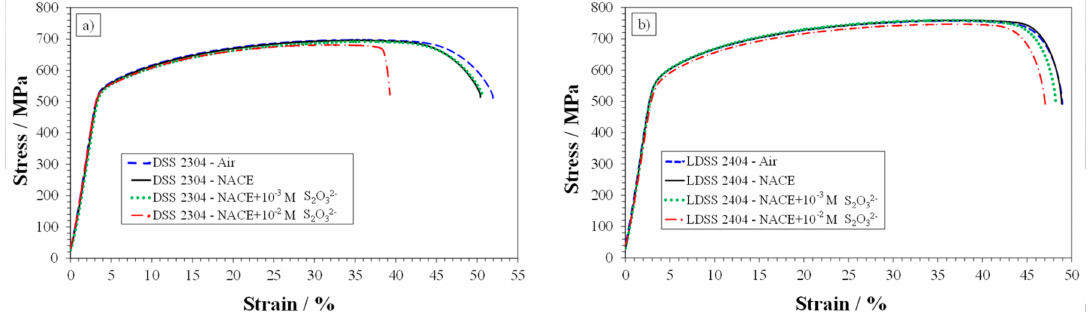
Figure 10. Stress–strain curves obtained during SSRT performed in air at 25 ◦ C and in NACE TM-0177 solution at 25 ◦ C and pH 2.7, in the absence and in the presence of 10 − 3 or 10 − 2 M S 2 O 32 − on DSS 2304 ( a ) and on LDSS 2404 ( b ).